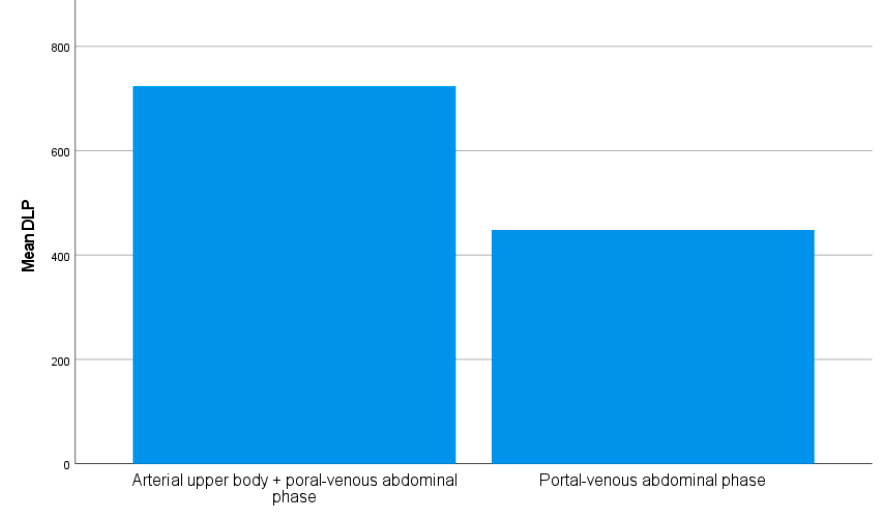
Figure 4. The mean dose-length product (DLP) can be reduced by 38% if the arterial contrast phase is